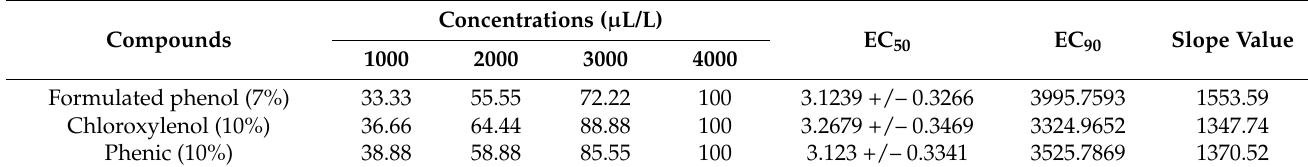
Table 5. Inhibitory effect (%) of antiseptic and disinfectant agents tested at different concentrations against S. rolfsii in vitro.